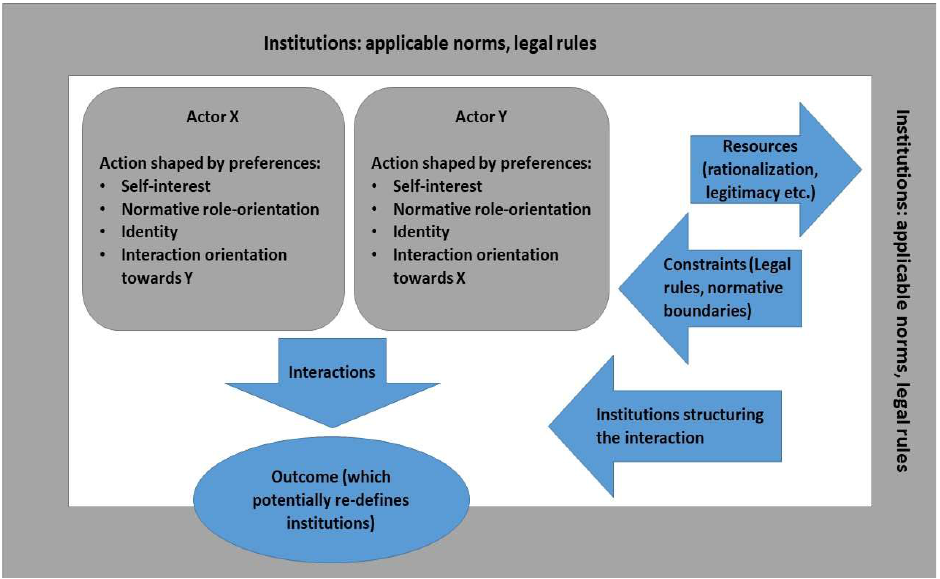
Figure 1. Central elements of actor-centered institutionalism [15].